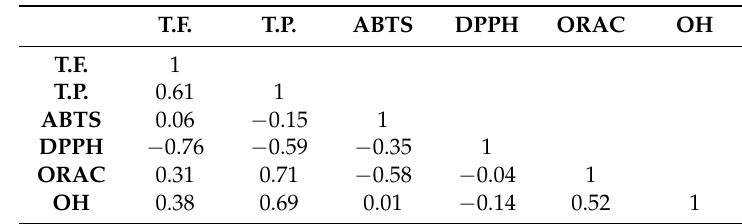
Table 7. Correlations between phenolic and flavonoid compounds and antioxidant properties of guava